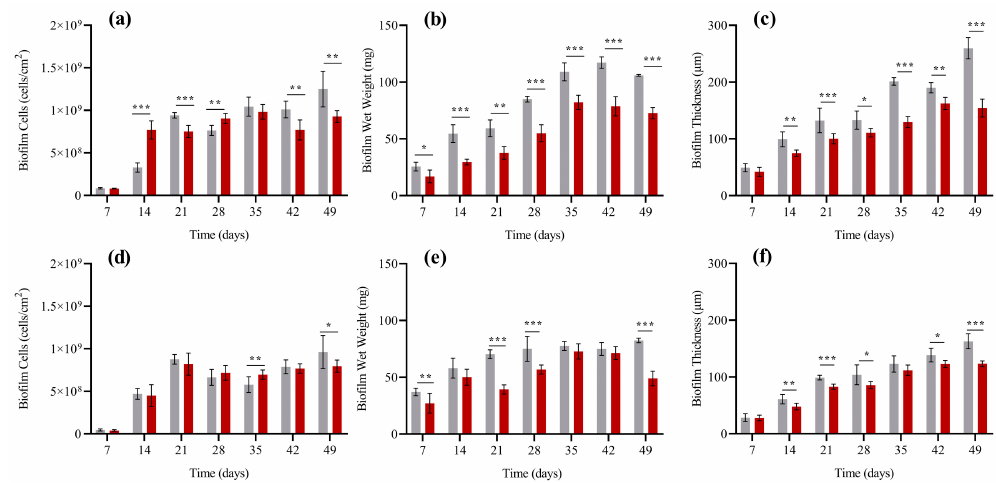
Figure 2. Effect of two commercial coatings ( ■ EpoRef; ■ SilRef) on biofilm development of Cyanobium sp. LEGE 10375 ( a – c ) and Pseudoalteromonas tunicata ( d – f ) for 49 days. The analyzed parameters refer to the number of biofilm cells ( a and d ), biofilm wet weight ( b and e ), and biofilm thickness ( c and f ). Statistical analysis was performed by paired t -test, and significant differences between the two surfaces are indicated with *** ( p < 0.01), ** ( p < 0.05), and * ( p < 0.1).